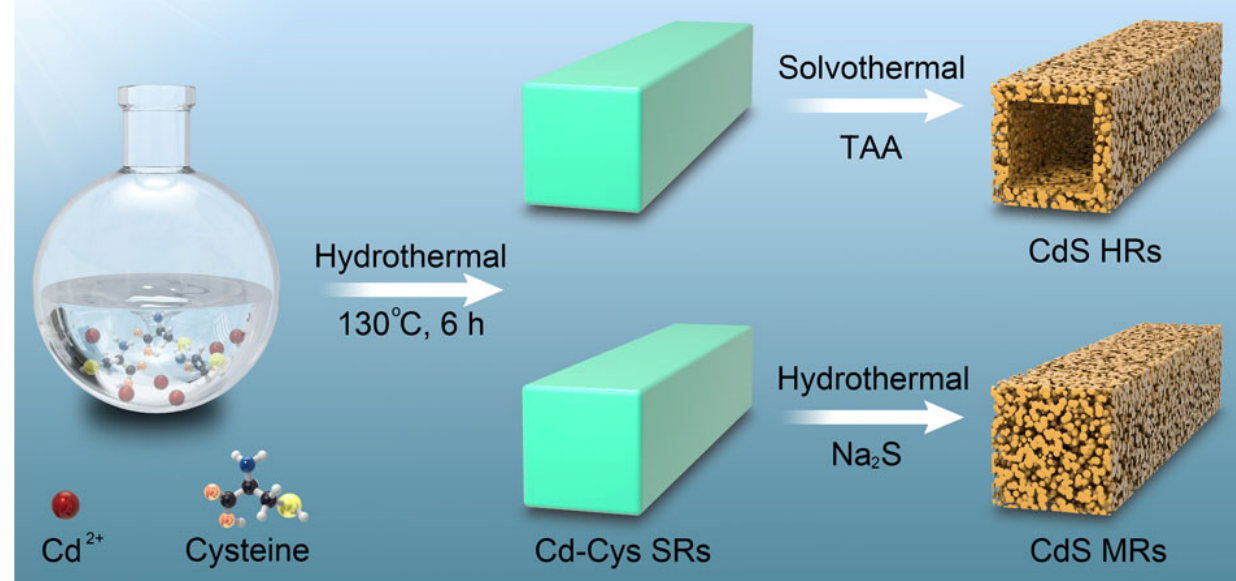
Figure 1. Schematic illustration of the synthesis of CdS HRs and CdS MRs. FESEM and TEM were adopted to monitor the evolution of the surface, morphology, and microstructure of the samples. It can be seen from Figure 2a that the Cd-Cys SRs are uniform and the surface of the rod is very smooth. After vulcanization, the Cd-Cys SRs are transformed into the CdS MRs and CdS HRs. As shown in Figure 2b, the surface of CdS MRs is composed of small-sized CdS nanoparticles. As can be seen from Figure 2c, the surface of CdS HRs is composed of CdS nanoparticles with pores on them. There are distinct cavities at the ends of the broken rods. Figure 2d shows the CdS MRs formed by connecting fine CdS nanoparticles (about 10 nm) with tiny gaps between them. Figure 2e shows that the surface of the CdS HRs is composed of rice-like CdS nanoparticles (about 40 nm) and that the internal cavity is obvious. During the vulcanization reaction, there is an obvious gap between the CdS shell and Cd-Cys core, forming a unique core–shell nanostructure in the structural intermediate (see Supplementary Materials Figure S1). In the high-resolution TEM image (Figure 2f), the surface nanoparticles are very crystalline and the lattice spacing is 0.34 nm, corresponding well to the (002) crystal plane of the wurtzite CdS crystal. To better reveal the advantages of the CdS HRs, CdS solid spheres (SSs) were also synthesized as counterparts (see Supplementary Materials Figure S2). The crystallographic structure and phase composition of as-prepared samples were further characterized by XRD pattern, shown in Figure 3. All the diffraction peaks of Cd-Cys SRs belong to the orthorhombic crystal system [27]. After vulcanization, all the XRD peaks pointed to the hexagonal wurtzite CdS crystals (JCPDS 41-1049). The XRD results indicate a complete phase transformation from Cd-Cys SRs to CdS HRs. The XRD pattern also indicated that the MRs were wurtzite CdS crystals. However, the crystallinity was not as good as that of CdS